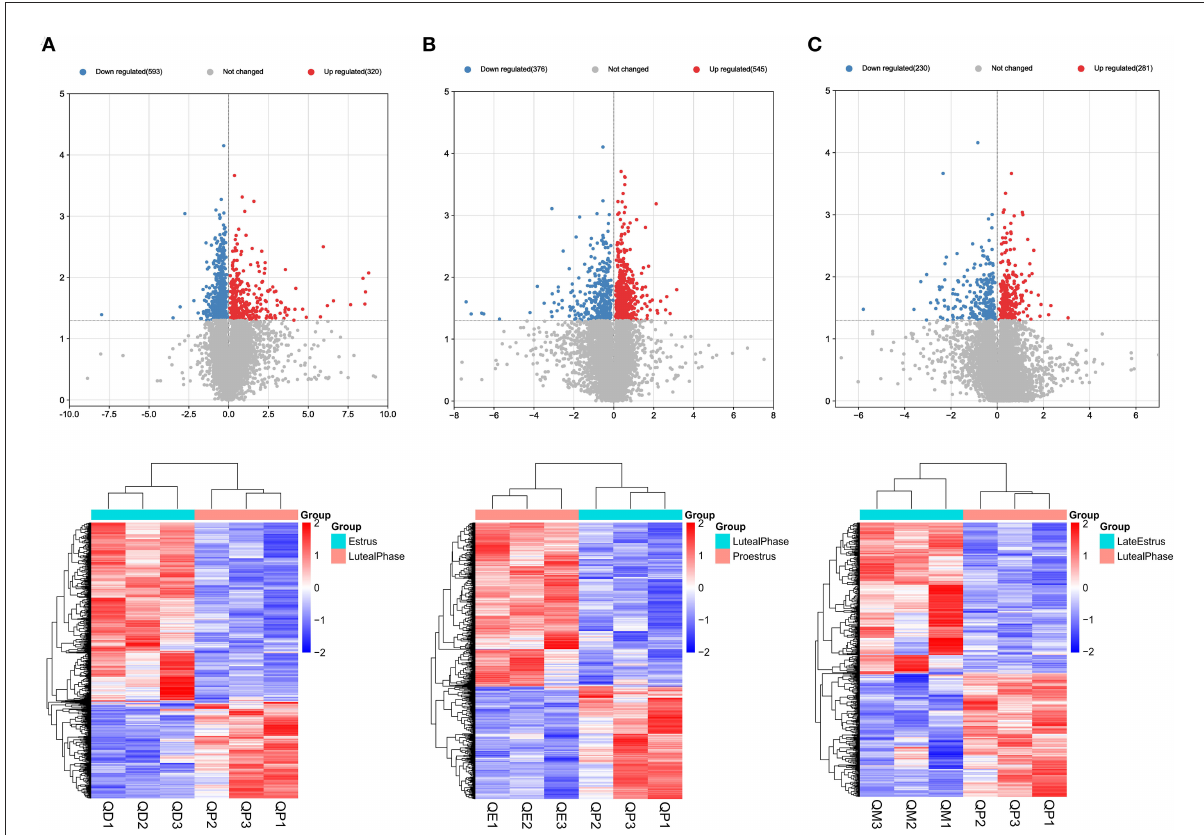
FIGURE1 Graphical representation of DEmRNAs at each stage of the estrous cycle in sheep. The Volcano map and Hierarchical clustering analysis of DEmRNAs in the QD-QP (A) , QE-QP (B) , and QM-QP (C) .